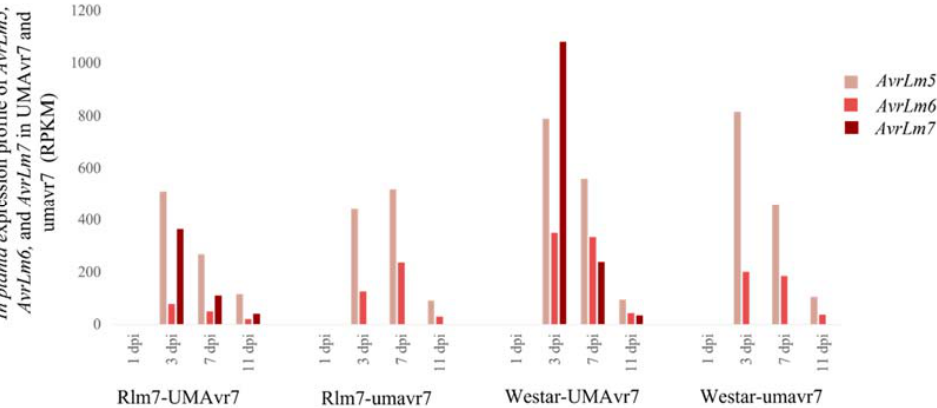
Figure 3. In planta expression of AvrLm5 , AvrLm6 , and AvrLm7 of Leptosphaeria maculans isolates UMAvr7 and umavr7 in infected host plants. Dual RNA-seq results exhibited in planta expression of AvrLm5 , AvrLm6 , and AvrLm7 in UMAvr7 and umavr7 isolates in both infected 01-23-2-1 (Rlm7 line) and Westar plants. The expression of AvrLm5 and AvrLm6 were observed in both isolates, while the expression of AvrLm7 was shown only in UMAvr7 isolate in both hosts. Results were representa ‐ tive of three biological replicates.